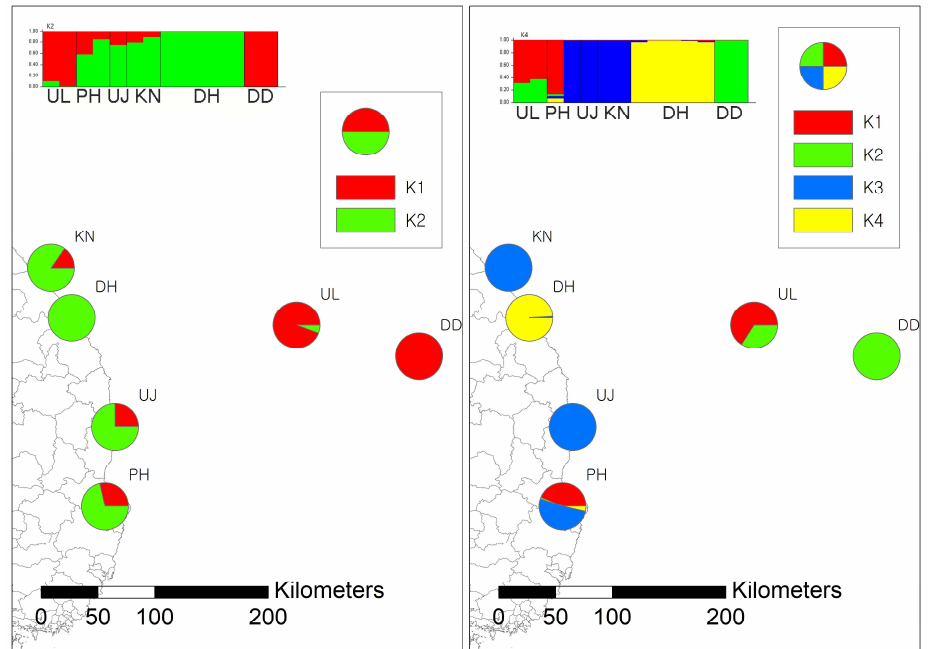
Figure 2. Spatial structure of 6 populations of Rattus norvegicus along the east coast with Ulleung-do and Dok-do. The bar and pie chart of clustering assignment for K = 2 ( left ) and 4 ( right ) assessed from STRUCTURE based on 4042 SNPs.